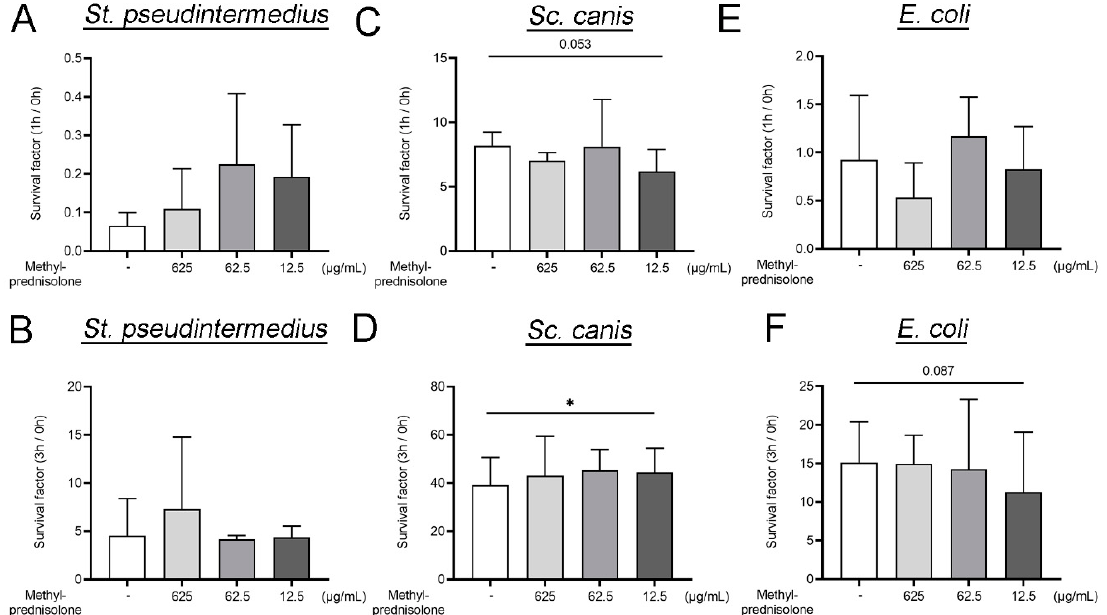
Figure A1. Gram positive and Gram negative bacteria can grow in the presence of methylprednisolone and canine plasma. The survival factor (SF) of bacteria were determined in the presence of different methylprednisolone concentrations, but without canine neutrophils as shown in Figure 1. ( A , B ) SF of St. pseudintermedius was not significantly influenced by methylprednisolone. ( C , D ) The highest SF of all analyzed bacteria was detected for Sc. canis in the presence of methylprednisolone (concentration 12.5 µ g/mL). ( E , F ) The SF of E. coli was not significantly influenced by methylprednisolone over time at all. All graphs show the mean ± SD of three independent experiments with 10% plasma of three different donor dogs. Statistical differences were detected by one ‐ tailed paired Student’s t ‐ test calculated to the sample without methylprednisolone. Statistical results are presented for values lower than 0.1 and higher than 0.05 as Arabic numbers and as the following: *, p <